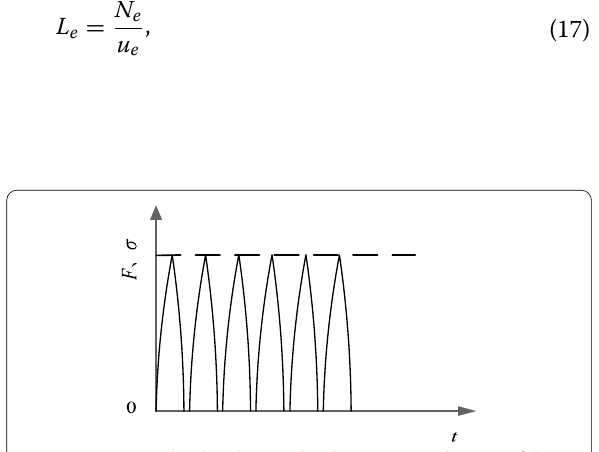
Figure 7 Contact load and stress distributions at each point of the stationary